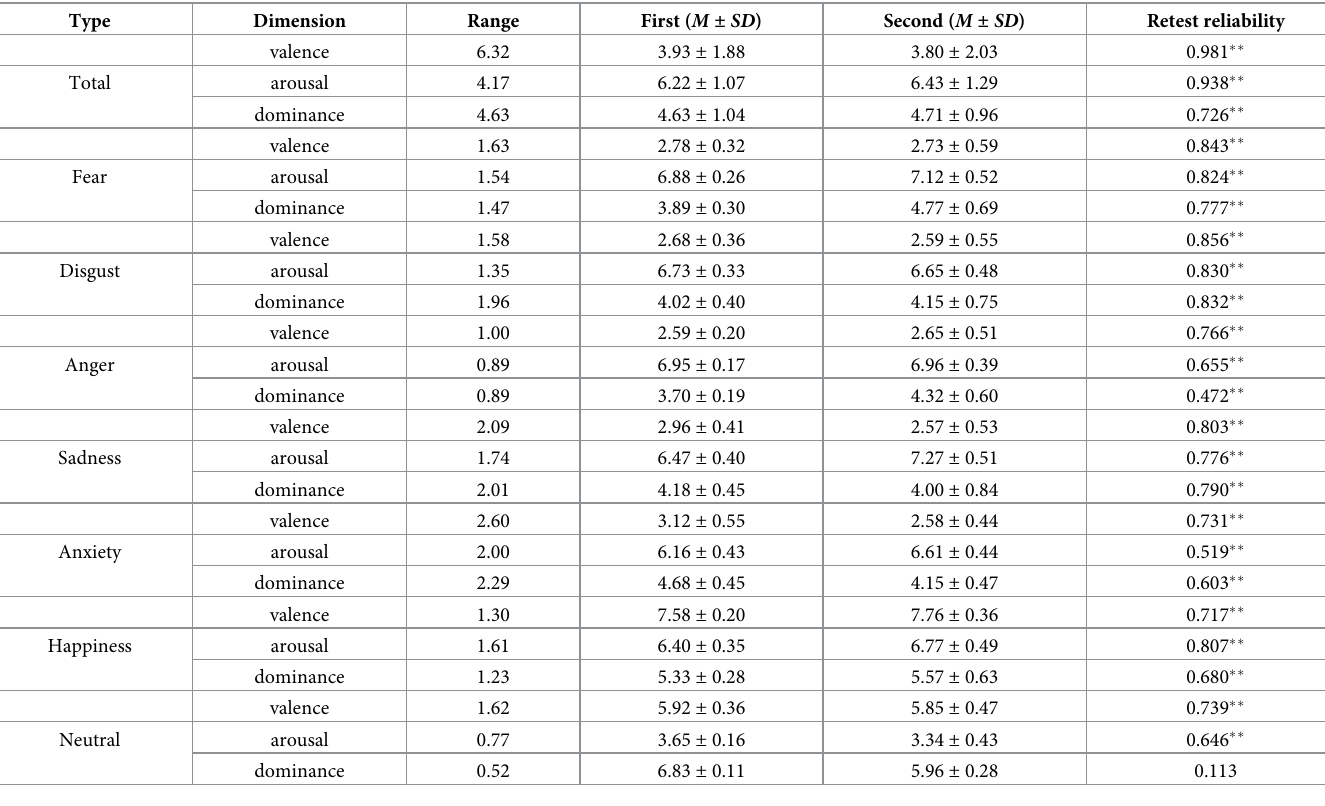
Table 1. Descriptive statistical analysis and retest reliability of the